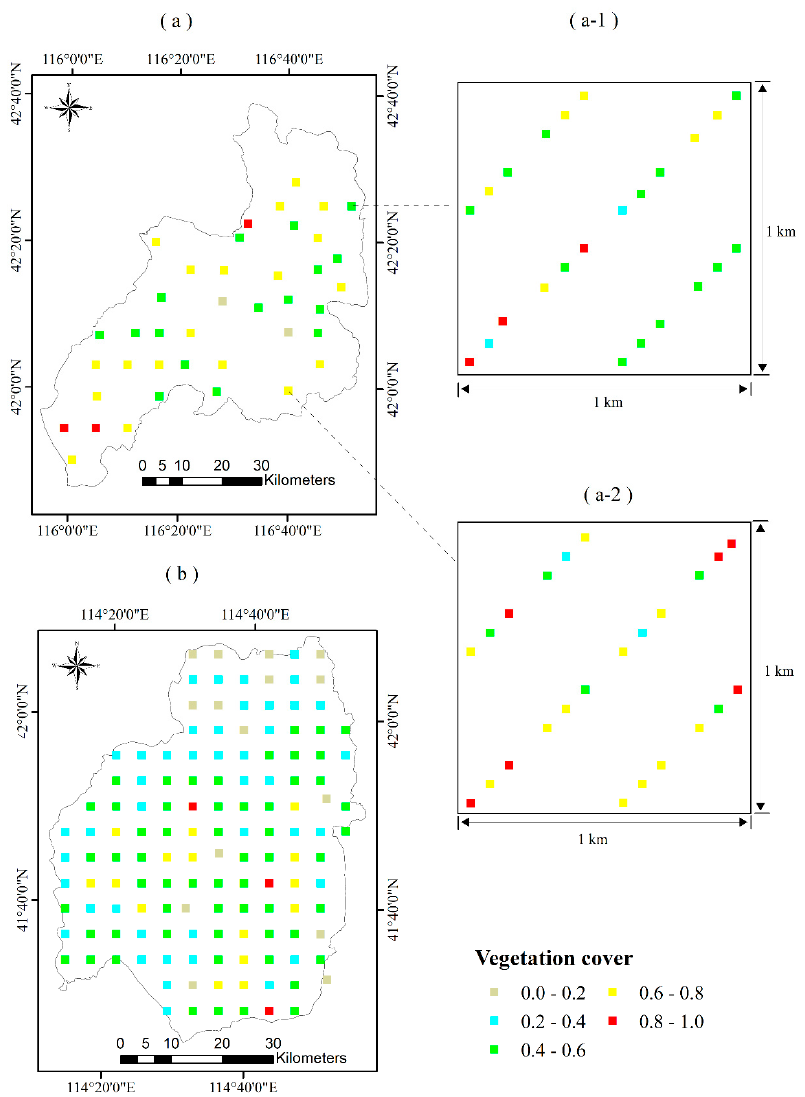
Figure 3. The spatial distribution of plot percentage vegetation cover (PVC) values for ( a ) Duolun County with ( a-1 ) and ( a-2 ): two examples of spatial distribution of 30 m × 30 m plot PVC values within 1000 m × 1000 m blocks; and ( b ) Kangbao County.